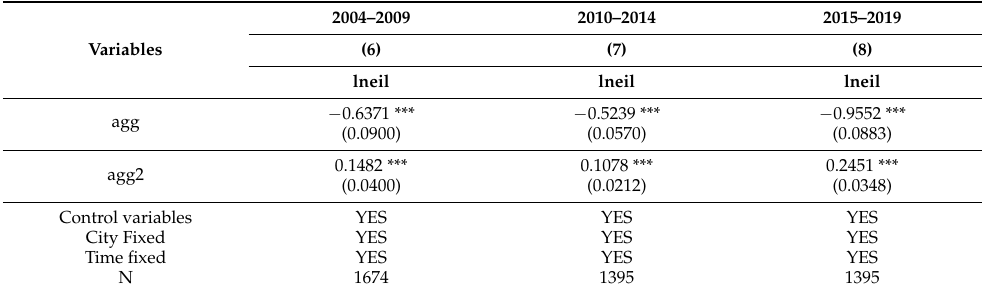
Table 6. Robustness test results.